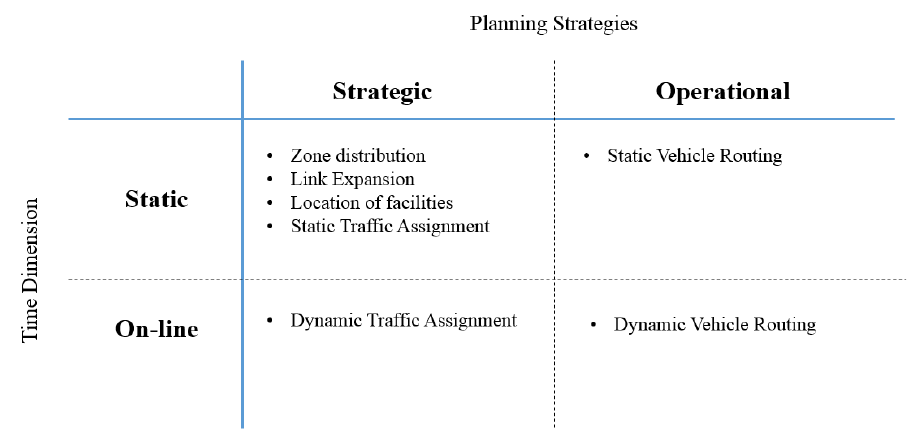
Figure 1. Some of the operational research problems that can be considered when planning for urban design.